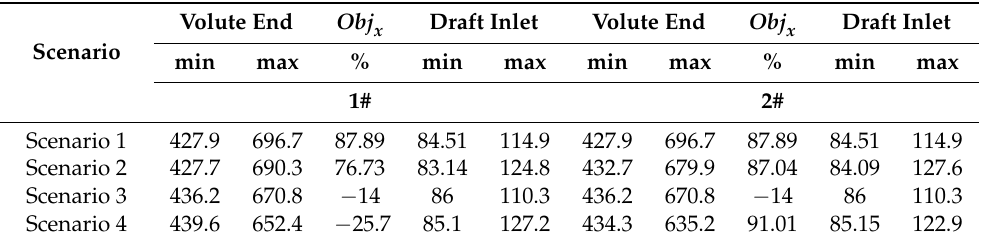
Figure 12. The transient process of 15 schemes by different scenarios: ( a ) guide vane closing laws; ( b ) rotational speed; ( c ) volute end pressure and ( d ) draft tube inlet pressure.